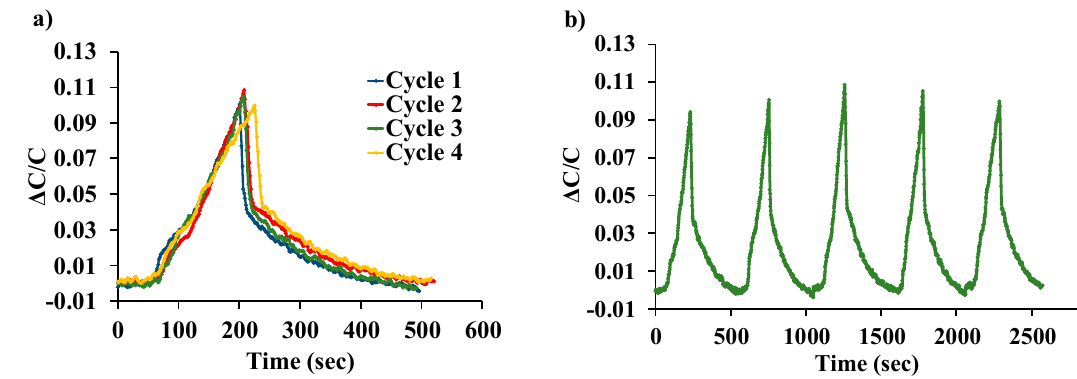
Figure 8. ( a ) Repeatability of LACM sensor tested over four cycles. ( b ) Sensor output over five consecutive cycles of exposure and removal of humidity.